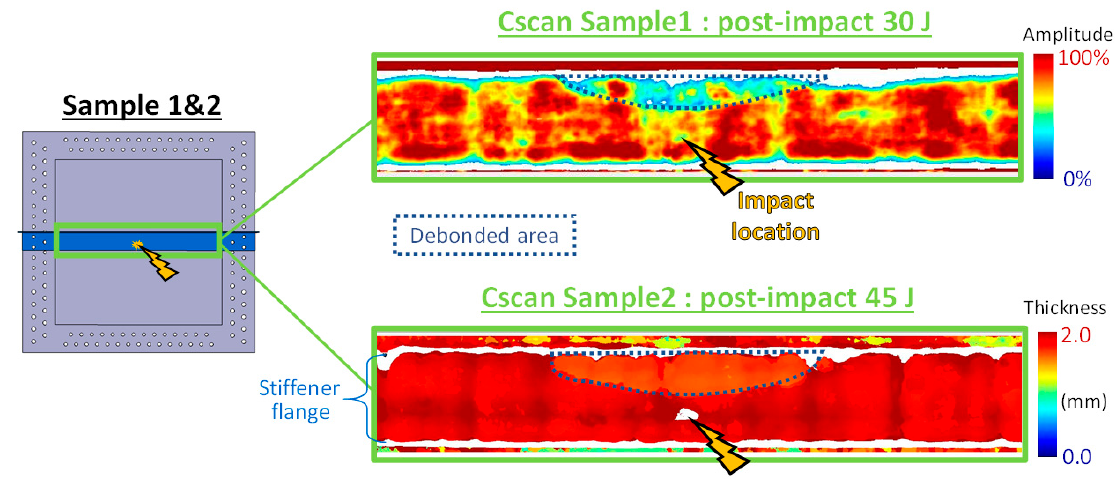
Figure 18. C-Scans of Sample1 and Sample2 revealing a debonded area between the skin and the stiffener, close to the impact location.